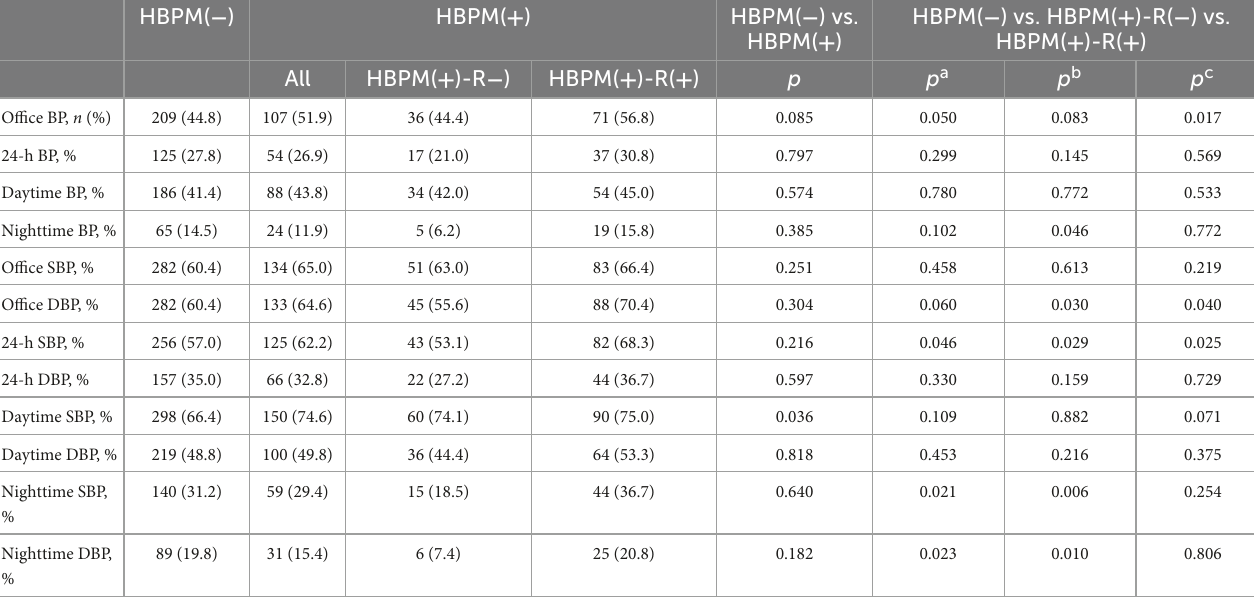
TABLE 4 Control rates of blood